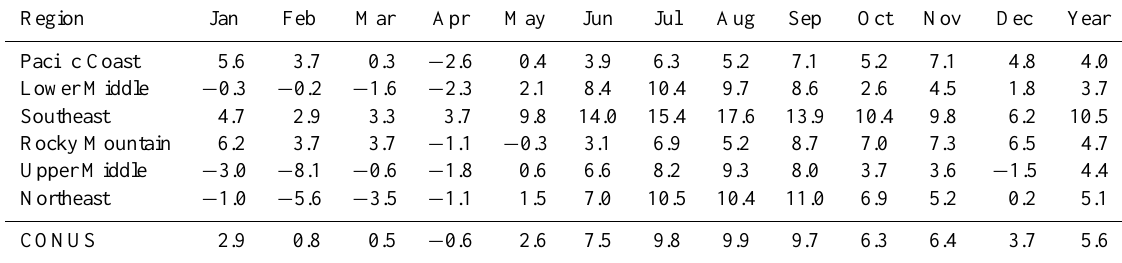
Table 1. Monthly and annual average ozone biases in different regions and CONUS in 2010. Unit: ppbv. Region Jan Feb Mar Apr May Pacific Coast Lower Middle − 0.3